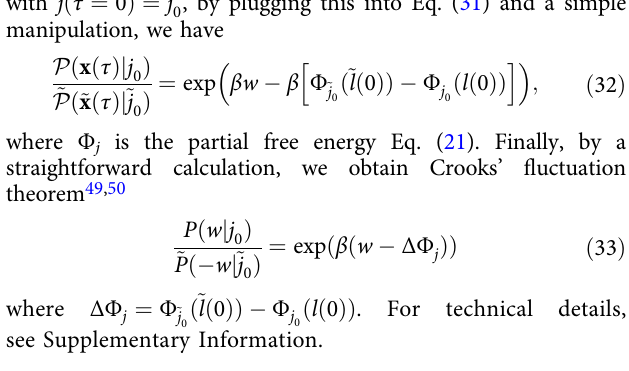
Fig. 3 Magnetization of the fully connected Ising model with molecule states for n = 50 and n = 200 particles, for a spin – spin coupling constant, J = 1. Results of the mean- fi eld approximation (solid lines) are in good agreement with Monte Carlo simulations (symbols). Errorbars show the standard deviation of the average value obtained from 1000 independent runs of the simulations (see Supplementary Information for more details). The inset shows the well-known result for the fully connected Ising model without molecule states. Without molecule formation, we observe the usual second-order transition. With molecules, the critical temperature decreases with the number of particles and the phase transition becomes fi